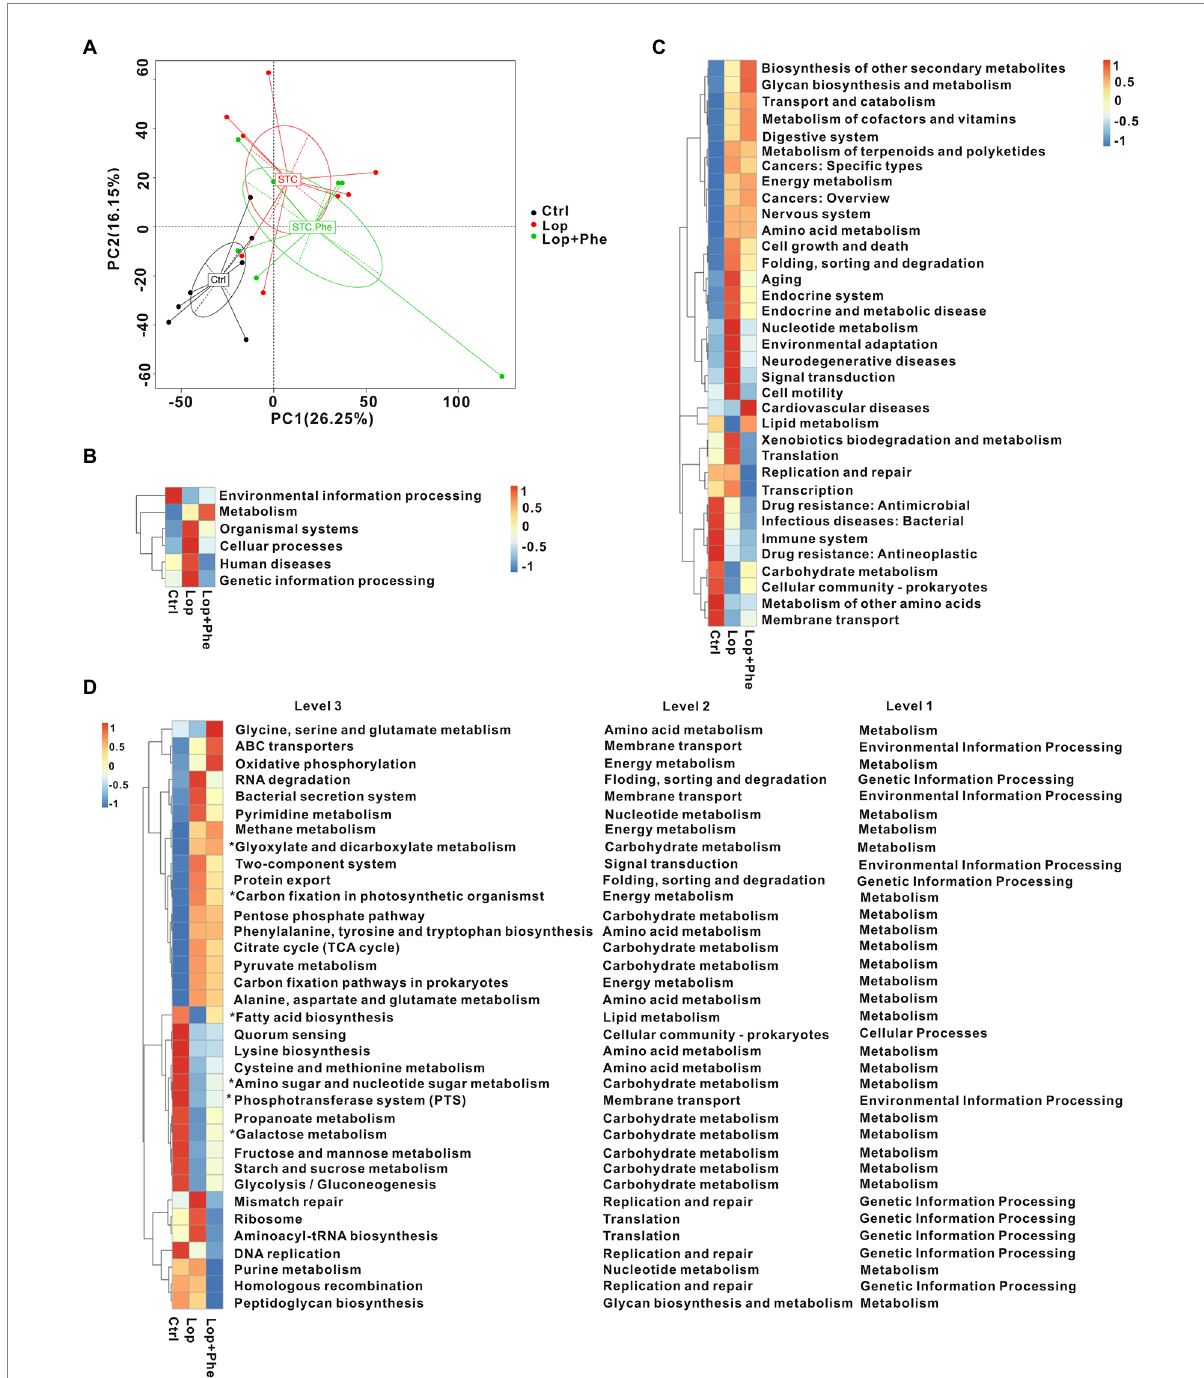
FIGURE 3 Microbial gene function prediction by KEGG analysis among the three groups. (A) PCA based on the Bray–Curtis distance of the KEGG model between the three groups. (B–D) Mean abundance of differentially enriched KEGG pathways among the three groups at level 1, level 2, and level 3. * p < 0.05, Kruskal–Wallis H